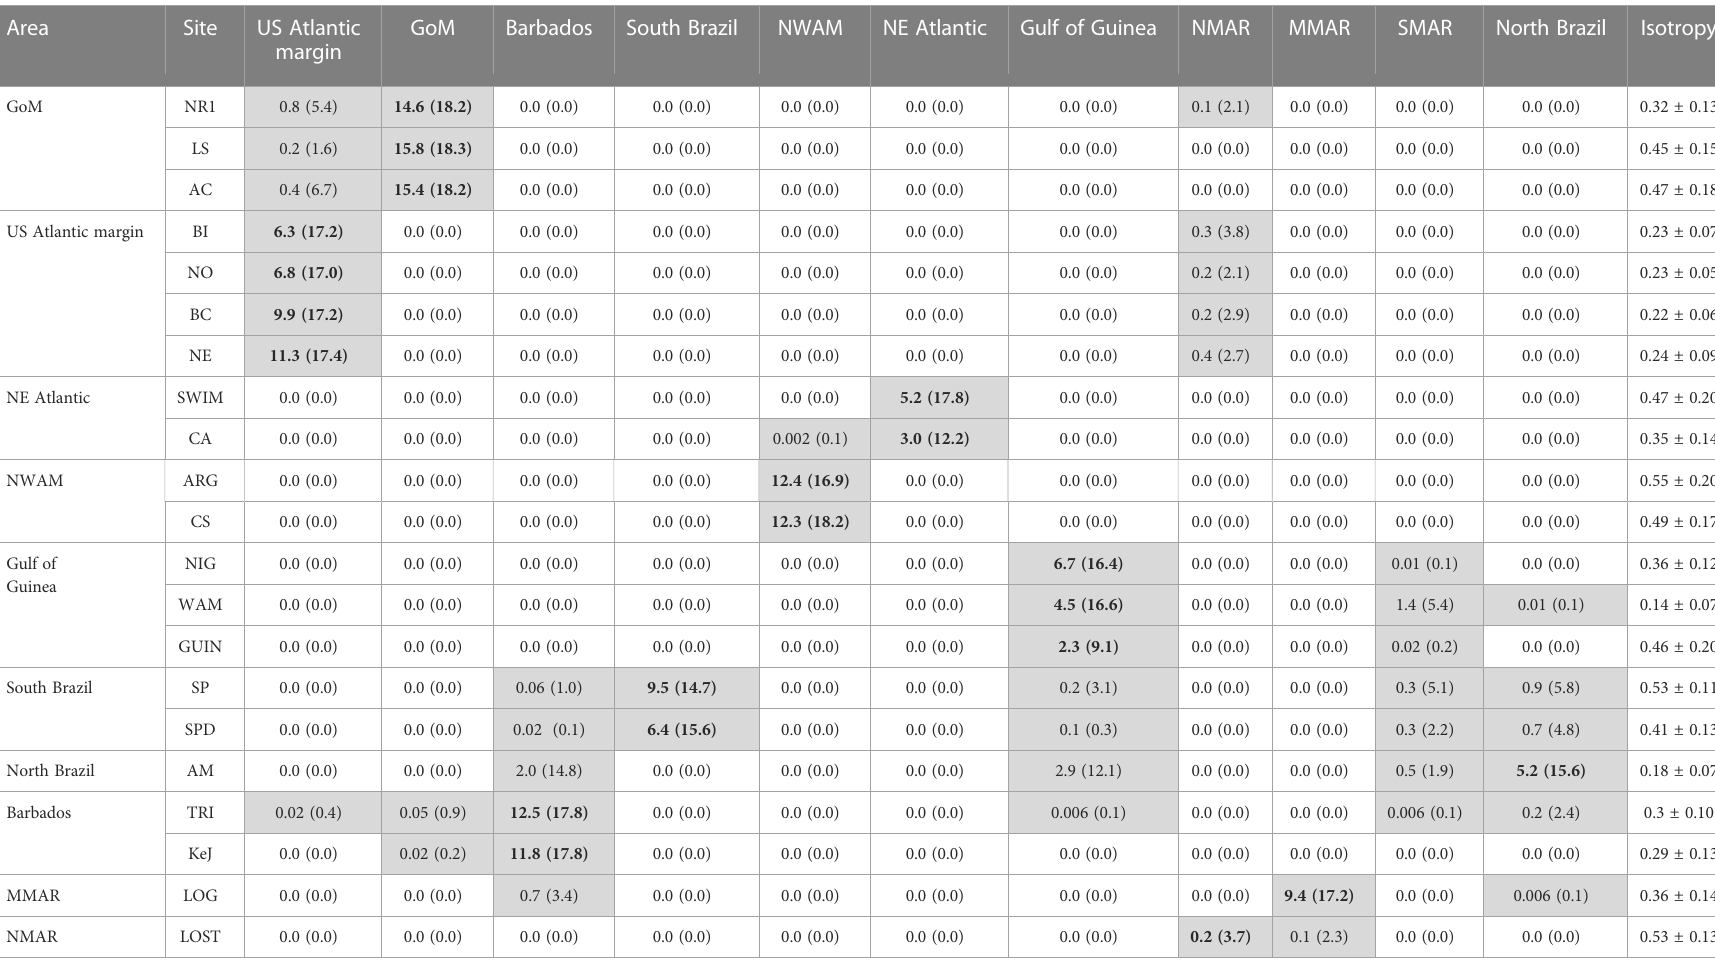
TABLE 6 Mean and maximal (in brackets) percentages of larval exchanges observed between spawning areas and the eleven regions for settlement (see Figure 1 for the mapping of these areas) using larval dispersal simulations of the oceanic circulation model